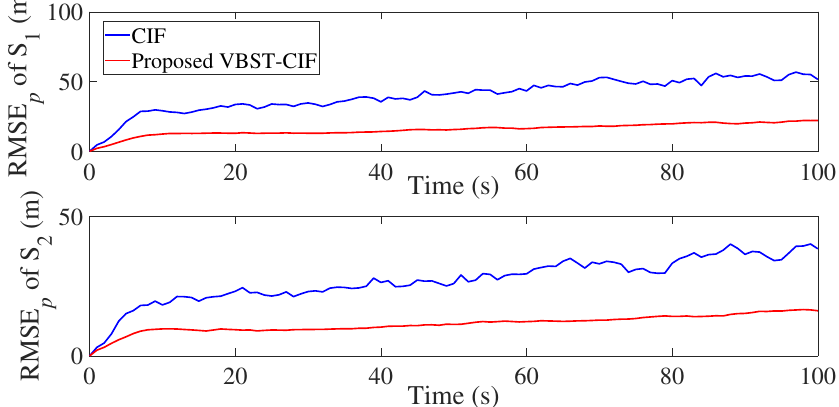
Figure 7. Position RMSE of different sensors in multi-sensor target tracking.